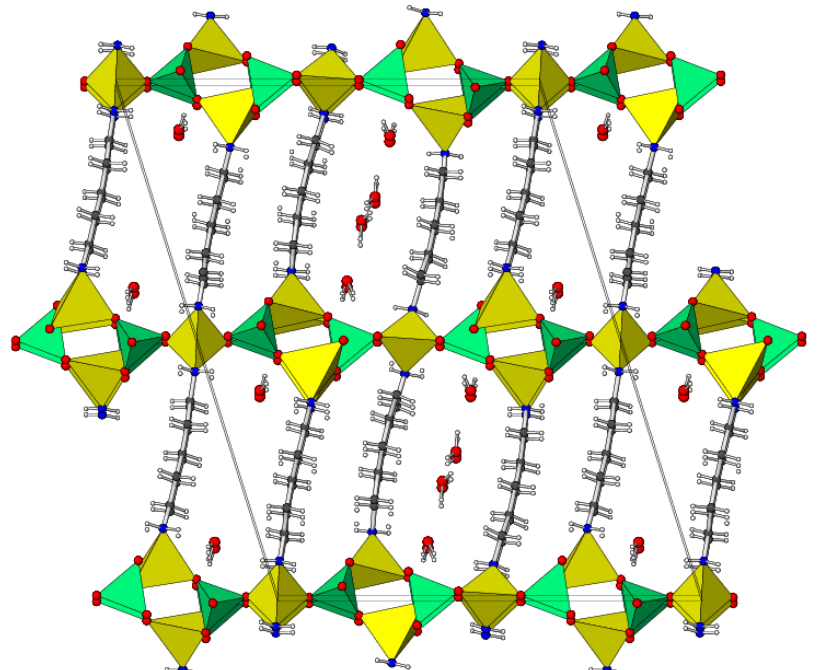
Figure 3. View approximately down [010] of the unit-cell packing in 1 , showing the three types of elongated channels with different water-molecule occupancies (see text). Color key as for Figure 2; in addition, C dark grey, H